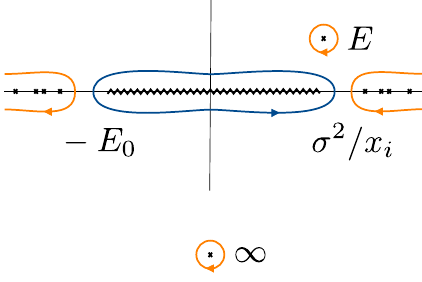
Figure 7: Contours and their deformation relevant for computing (90). In blue the initial contour C and in orange the deformed